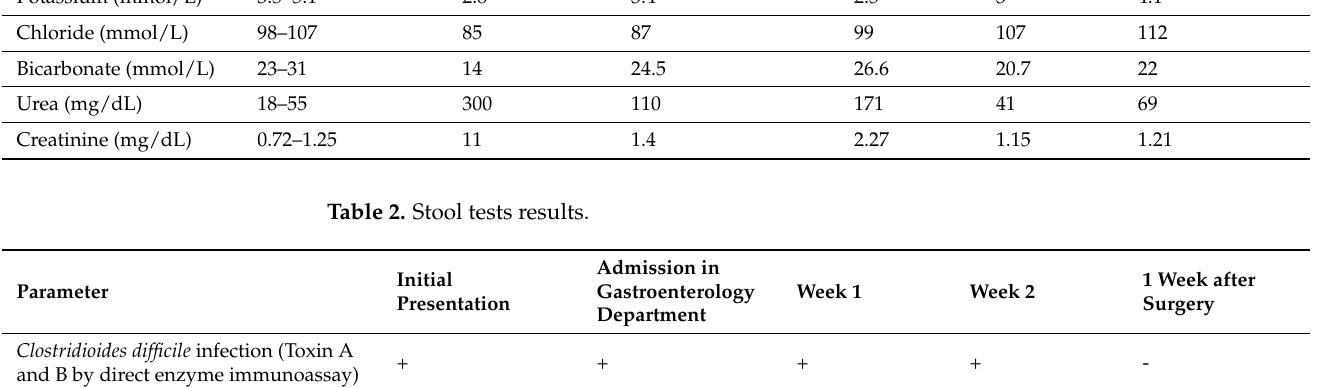
(Table 1). Digital rectal examination revealed a soft spongy mass at